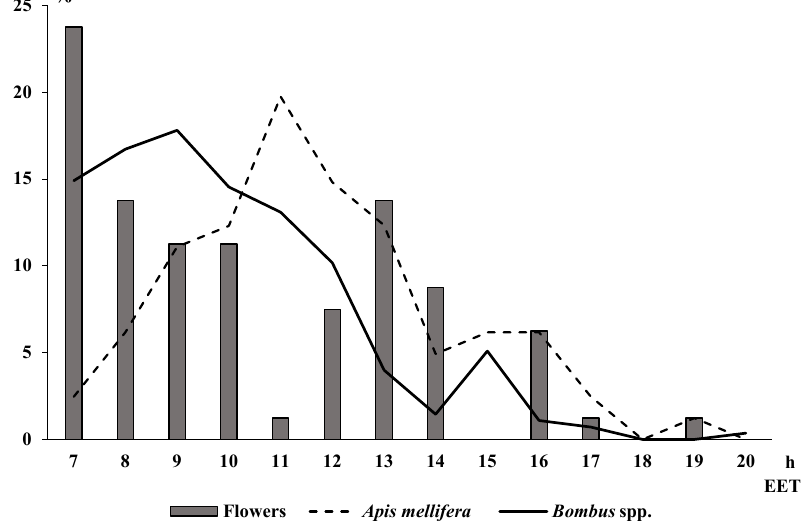
Fig. 2 Diurnal pattern of flowering of Hyacinthus orientalis ‘Sky Jacket’ expressed as the number of flowers opened at 1-h intervals in relation to the total opened during the day and the diurnal activity of insect visitors observed in SE Poland (means calculated from 2013–2015; EET – Eastern European